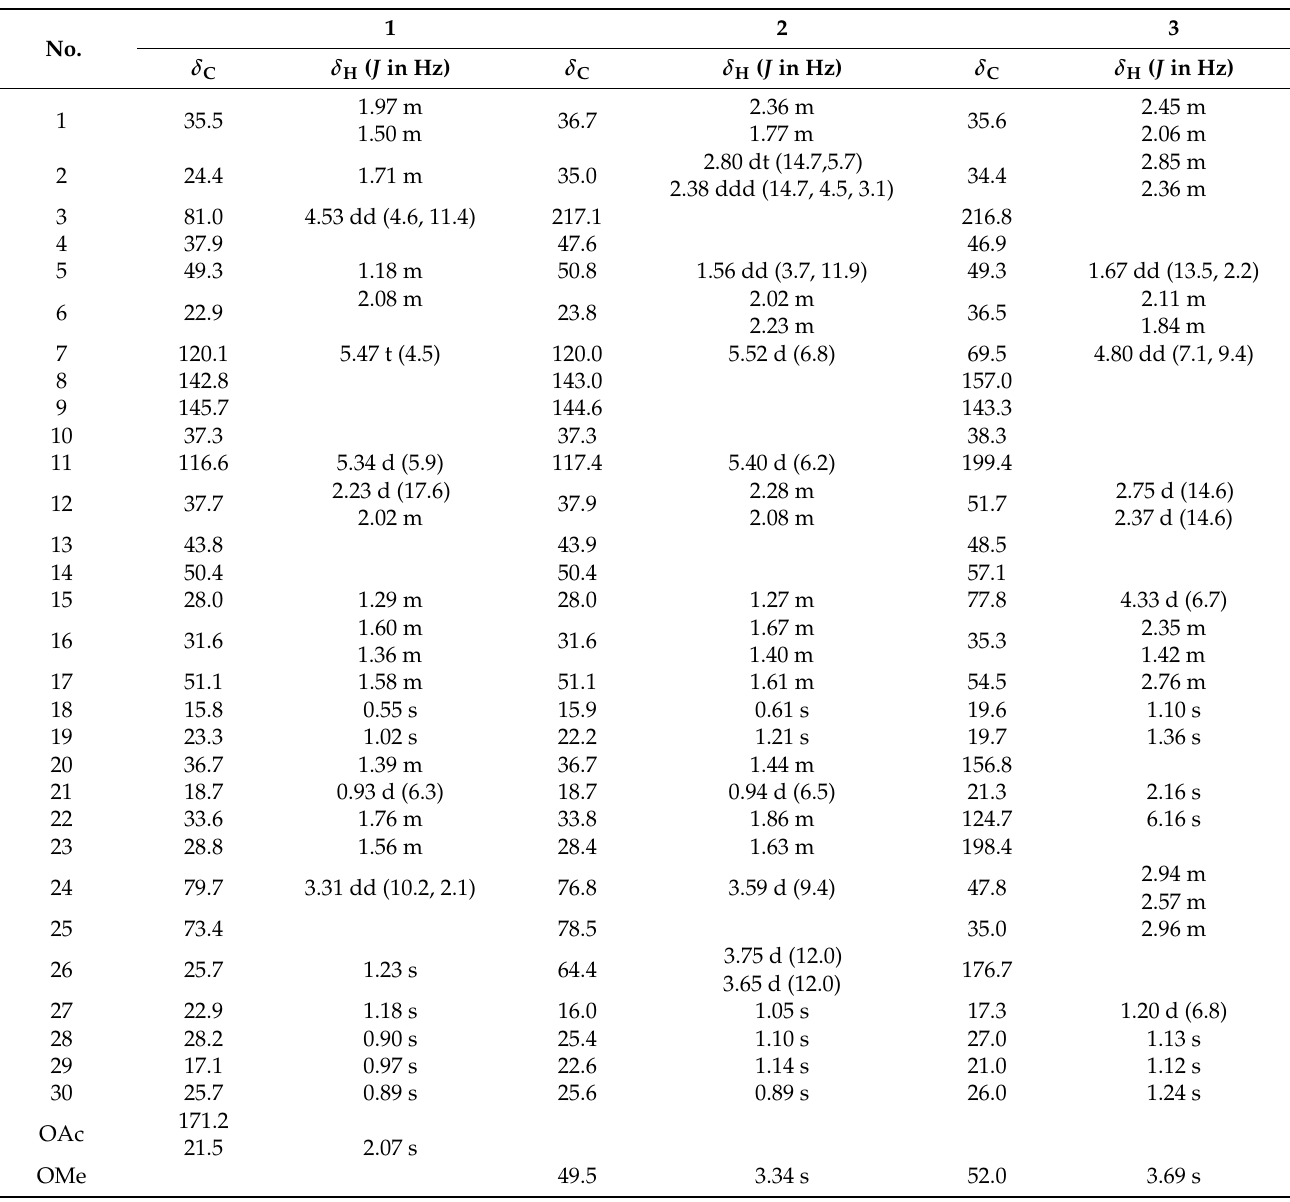
(Figure 2) of 1 from H 3 -28 ( δ H 0.90) and H 3 -29 ( δ H 0.97) to C-3, C-4 ( δ C 37.9), and C-5 ( δ C 49.3); from H 3 -18 ( δ H 0.55) to C-12 ( δ C 37.7), C-14 ( δ C 50.4), and C-17 ( δ C 51.1); from H 3 -19 ( δ H 1.02) to C-1 ( δ C 35.5), C-5, and C-9 ( δ C 145.7); and from H 3 -30 ( δ H 0.89) to C-8 ( δ C 142.8), C-13 ( δ C 43.8) and C-15 ( δ C 28.0) further assigned its planar structure of lanos- tanoid. The relative configuration of the tetracyclic core structure of 1 was determined to be the same as that of lanosta-7,9(11)-dien-3b-acetyloxy- 24,25,26-trihydroxy by comparison of their NMR and ROESY spectroscopic data (Figure 1), revealing ROESY correlations of H-18 with H-19 and H-20 ( δ H 1.39). The key ROESY correlation of H-3 ( δ H 4.53) with H 3 -28 ( δ H 0.90) and H-5 ( δ H 1.18) suggested the assignment of their same orientation. Based on comprehensive analysis of 1D, 2D NMR, and HRESIMS spectrums (see Supplemen- tary Materials), the structure of compound 1 was elucidated to be lanosta-7,9(11)-dien-3 β -acetyloxy-24,25-diol. Table 1. 1 H (500 MHz) and 13 C NMR (125 MHz) Data of Compounds 1 – 3 (in CDCl 3